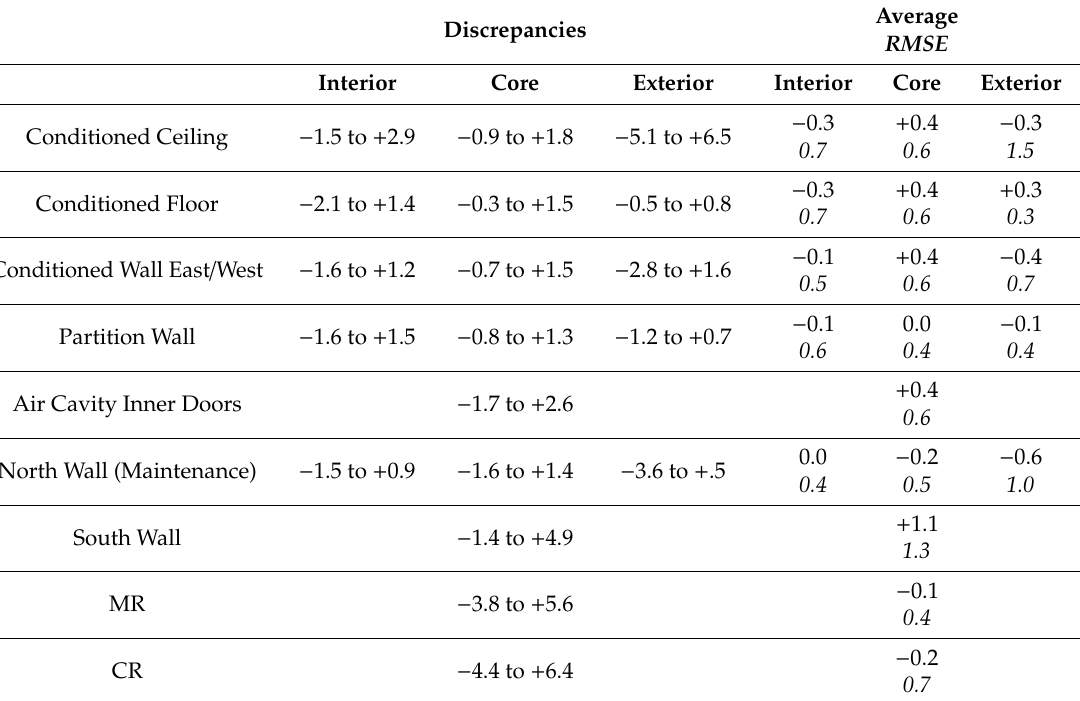
Table 4. Summary of insulation layer di ff